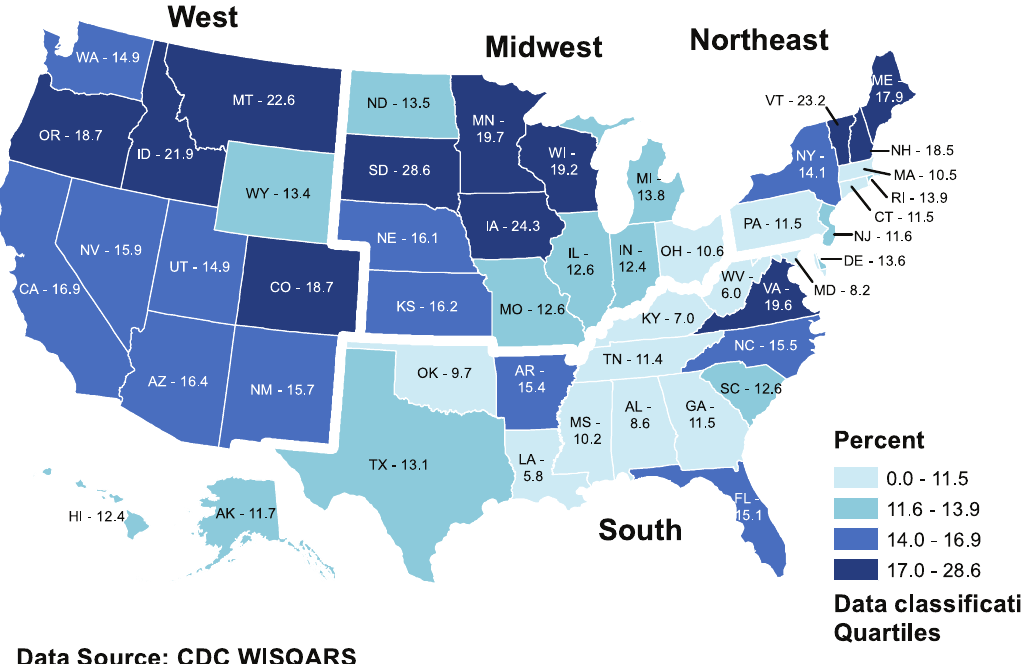
Fig 1. Percentage of nonhomicide drug-intoxication deaths classified as suicides in quartiles by state and region, United States, 2008 – 2010.